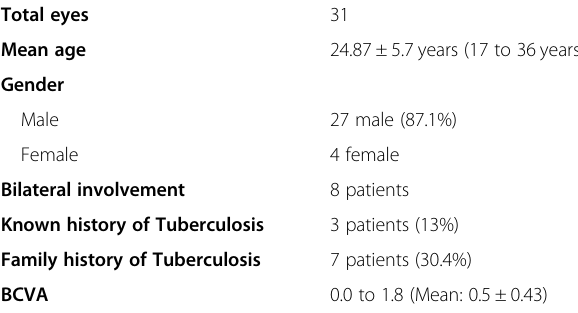
Table 1 Baseline characteristics of